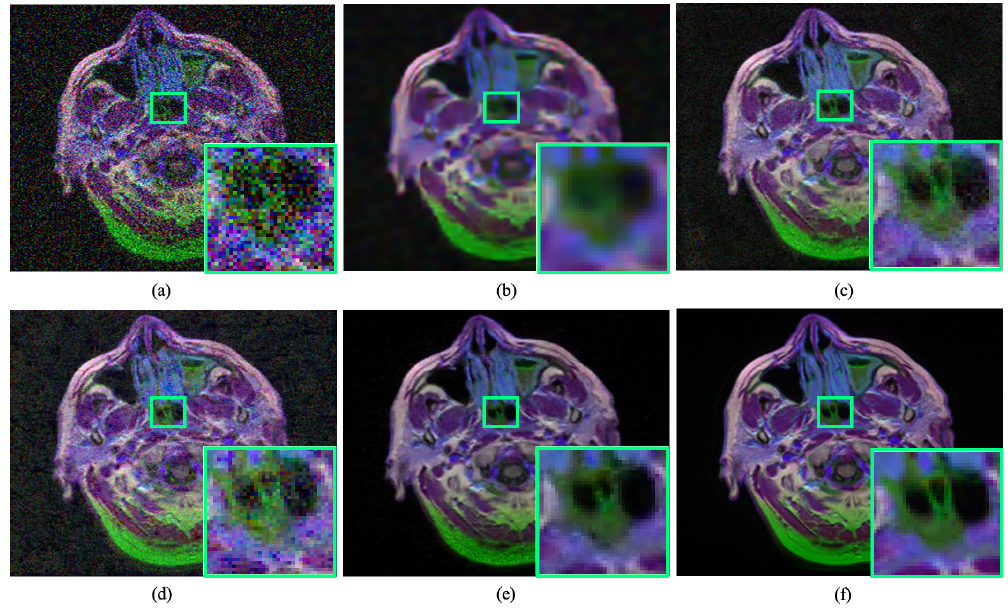
Figure 1. Performance of existing medical image denoising methods in removing image noise. The existing denoising methods immensely failed in addressing a substantial amount of noise removal and susceptible to produce artefacts. ( a ) Noisy input. ( b ) Result obtained by BM3D [11]. ( c ) Result obtained by DnCNN [16]. ( d ) Result obtained by Residual MID [12]. ( e ) Result obtained by DRAN (proposed). ( f ) Reference sharp image. Source by: